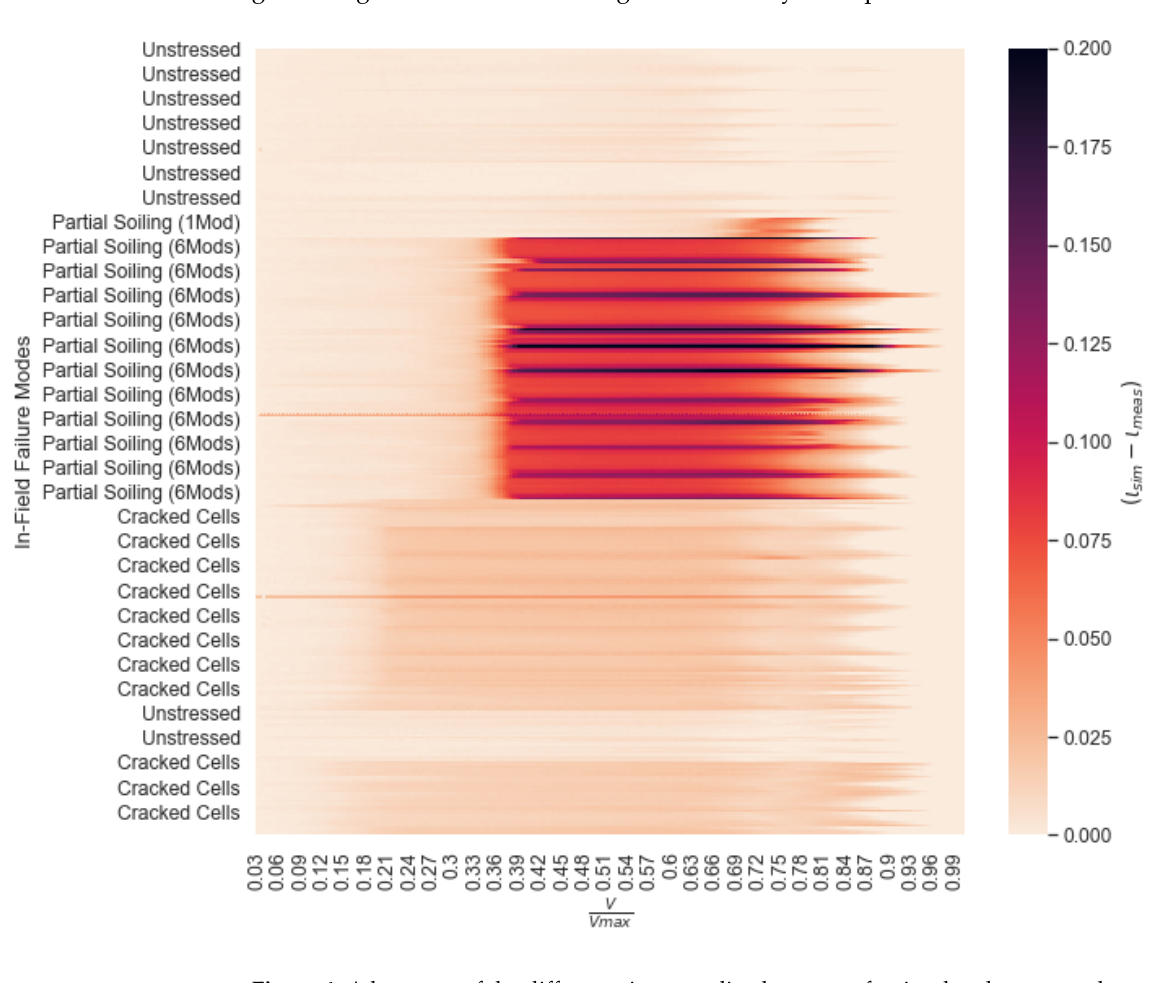
Figure 4. A heatmap of the difference in normalized current of a simulated unstressed curve (at the measured curve’s environmental conditions) and a measured curve displays profiles consistent with knowledge of the